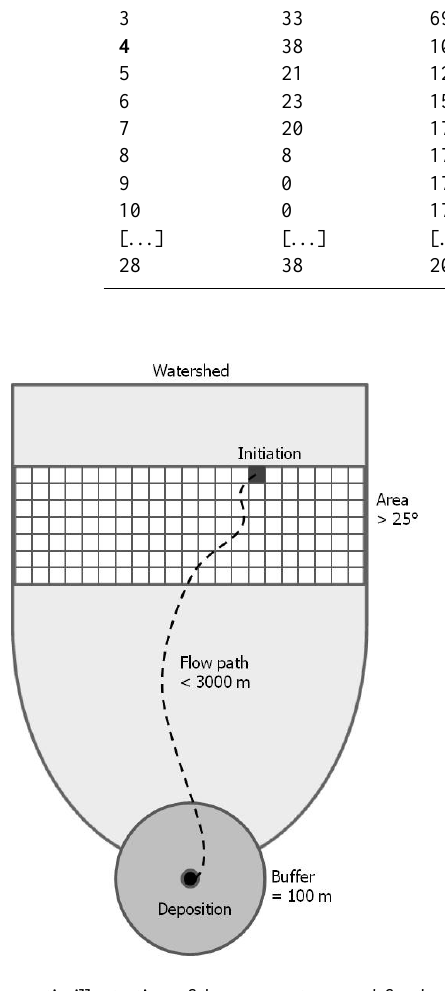
Fig. 3. Schematic illustration of the parameters used for the reloca- tion of recorded debris flows from the deposition to a likely initia- tion area.